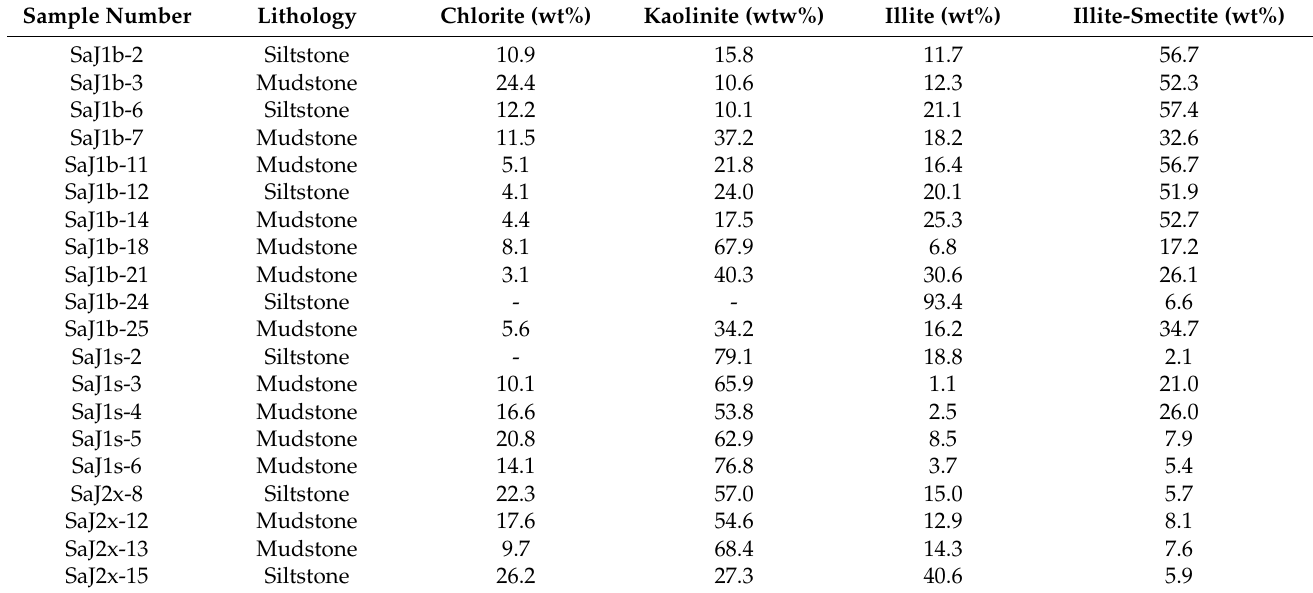
Table 2. Clay mineral data of samples from the Su’asugou section in Yili Basin, NW